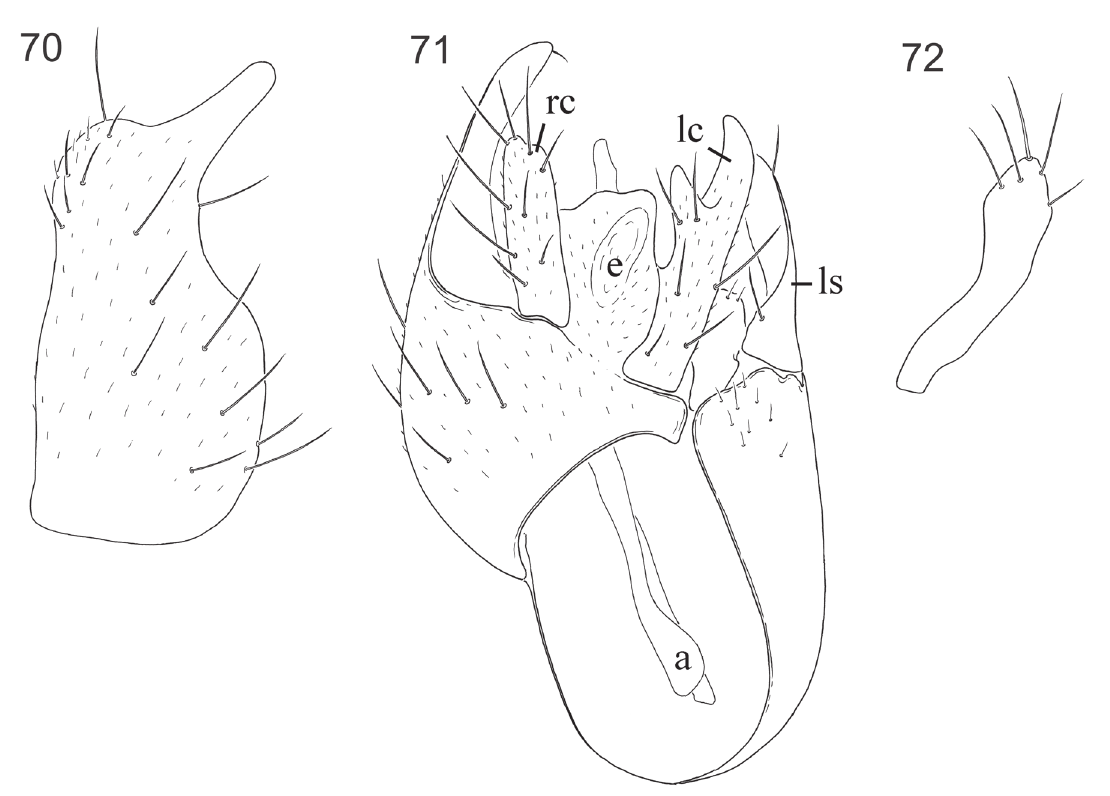
Figs 70-72. Chersodromia tiomanensis sp. nov., ♂ terminalia. 70 . right epandrial lamella, lateral view. 71 . epandrium and cerci, dorsal view. 72 . left surstylus, lateral